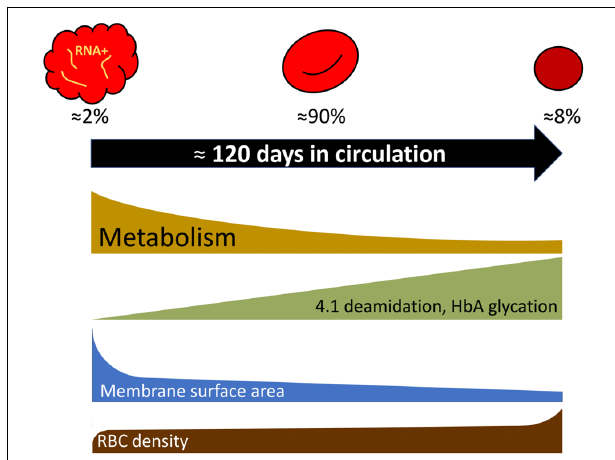
FIGURE 3 | Selected parameters that change during RBC aging following exponential or linear kinetics as cells turn from reticulocytes to mature cells and finally enter the senescent stage. Percentage of reticulocytes, mature cells, and dense senescent cells shown in the scheme correspond to those in adult healthy donors. For more details see Lutz and Bogdanova (2013) and the text.